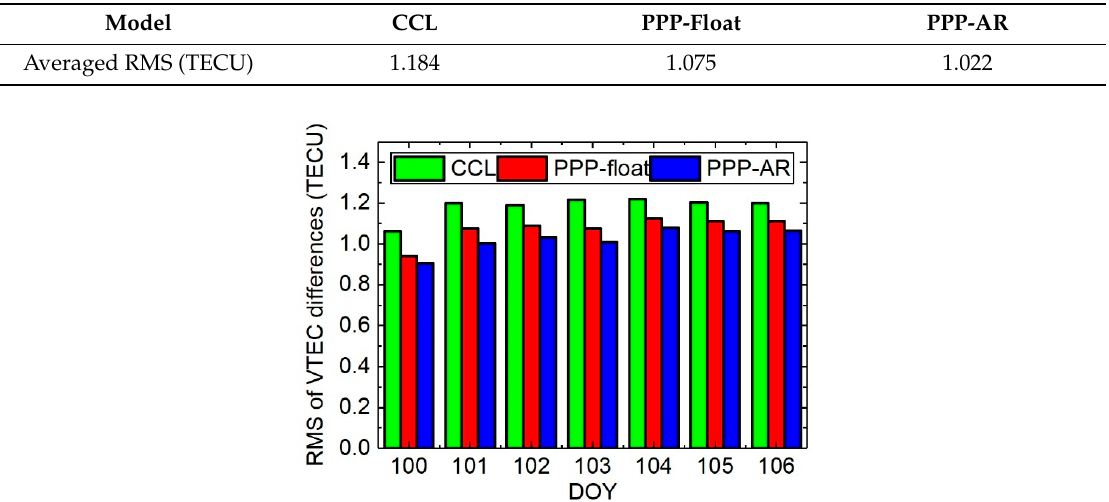
Figure 10. RMS of VTEC differences for the CCL, PPP-float, and PPP-AR GIM products compared to that of CODE GIM products from DOY 100 to 106, 2017.